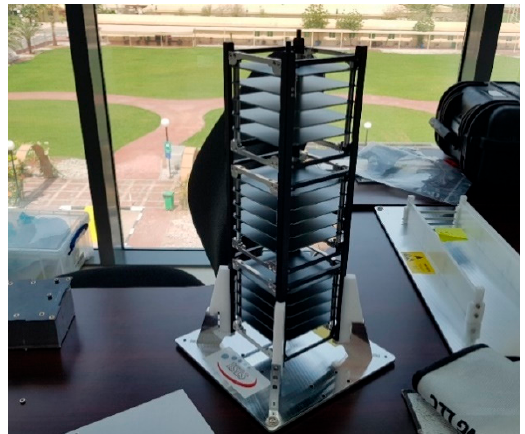
Figure 6. MeznSat mechanical structure.